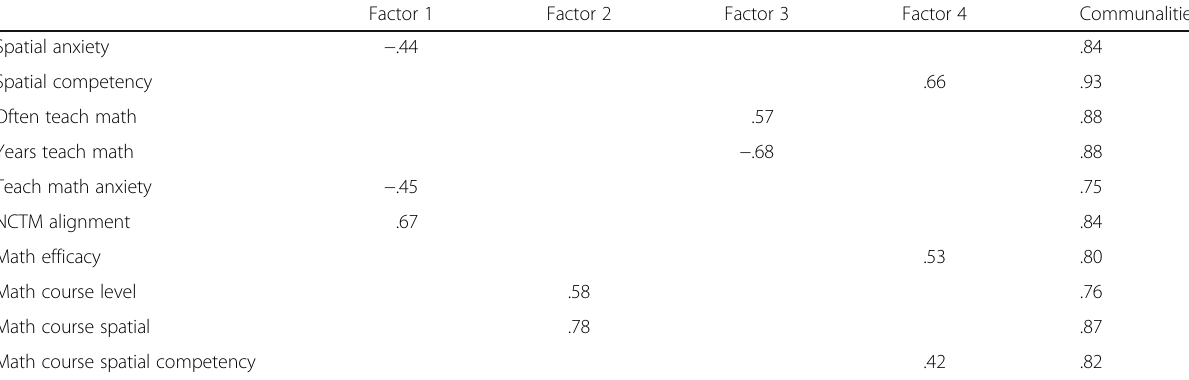
Table 5 Factor loadings and communalities from the exploratory factor